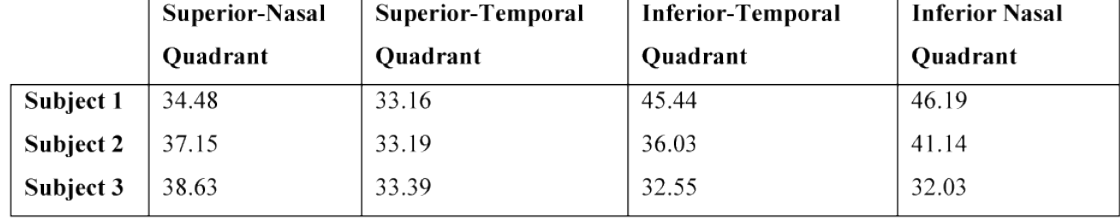
Table 2. Means for ocular ACA, in degrees, for the different quadrants for the right eyes of the three subjects are